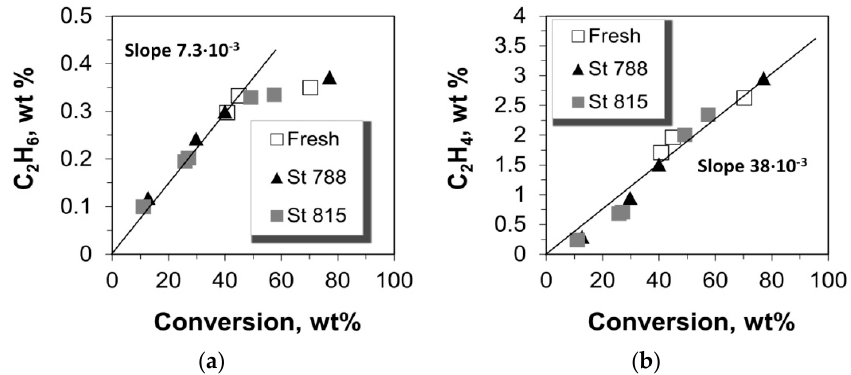
Figure 8. Production yields of ( a ) ethane and ( b ) ethylene versus the conversion of n-C 12 .